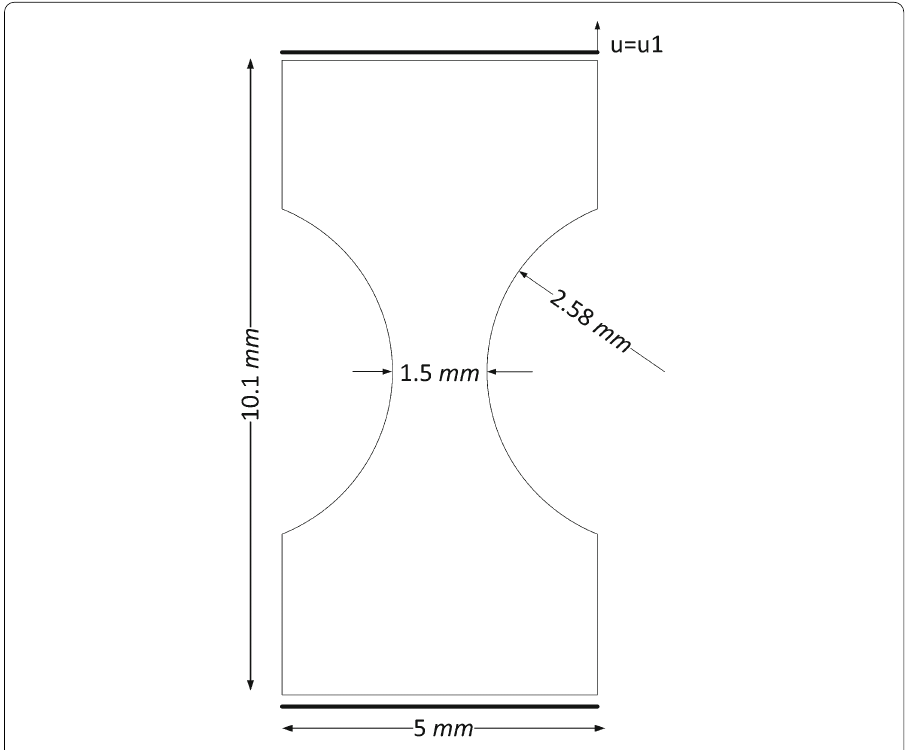
Fig. 3 Geometry and boundary conditions of the notched specimen